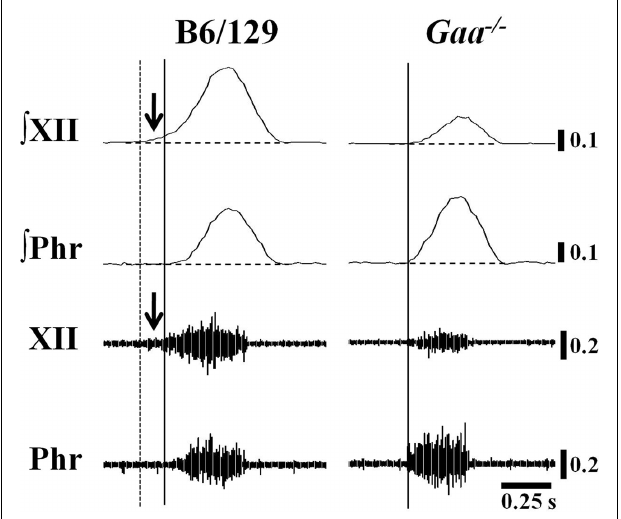
FIGURE 6 | Examples of Pre-I XII bursting in B6/129 and Gaa − / − mice. These examples were taken from vagotomized, ventilated mice.We noted anecdotally that Pre-I XII bursting (i.e., bursting before the onset of the phrenic burst) was evident in B6/129 but not Gaa − / − mice. In the examples, the solid vertical line indicates the onset of inspiratory phrenic bursting and the vertical dashed line represents the onset of Pre-I XII activity.The horizontal line indicates the end-expiratory amplitude prior to inspiration. This particular Gaa − / − mouse example was chosen to illustrate that in cases where Gaa − / − mice showed more robust phrenic bursting, the same animal tended to show reduced efferent XII output (see text for further